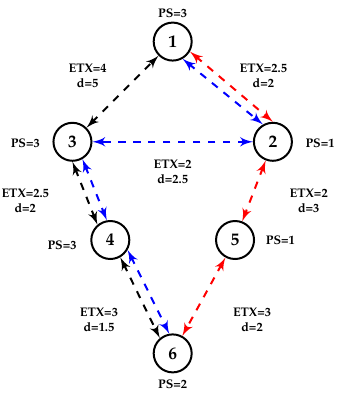
Figure 4. Network with different ETX , delay d (in ms) and PS